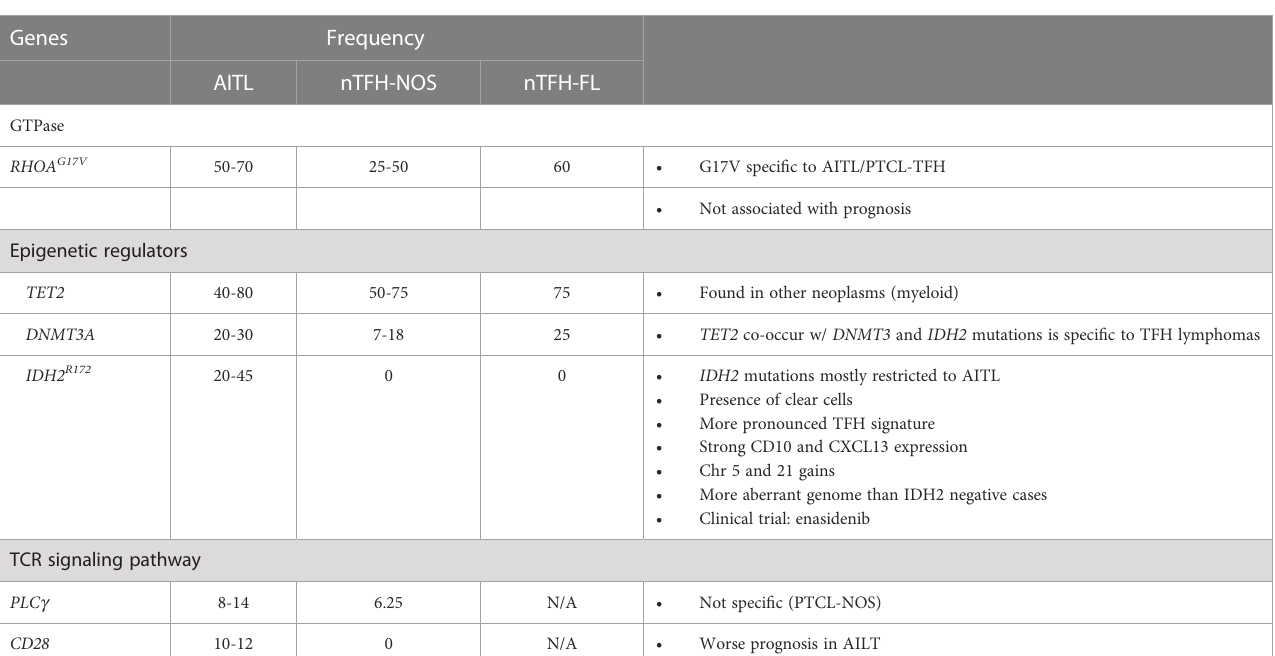
TABLE 2 Mutations associated with nodal follicular helper T cell